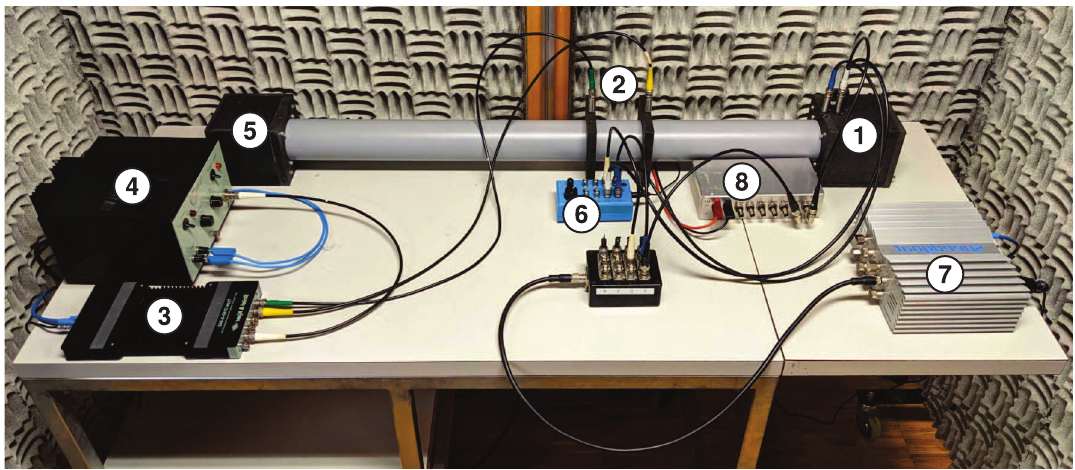
Figure 6. Experimental setup used to measure the impedance presented by the absorber. 1) Electroacoustic resonator; 2) Measurement microphones; 3) Frequency analyser; 4) Power ampli fi er; 5) Sound source; 6) IEPE signal conditioner; 7) FPGA controller; 8) current pump.